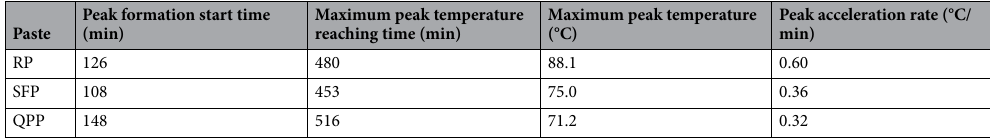
Table 4. Start/end times and maximum temperature of the exothermic peak in semi-adiabatic calorimetry curves.